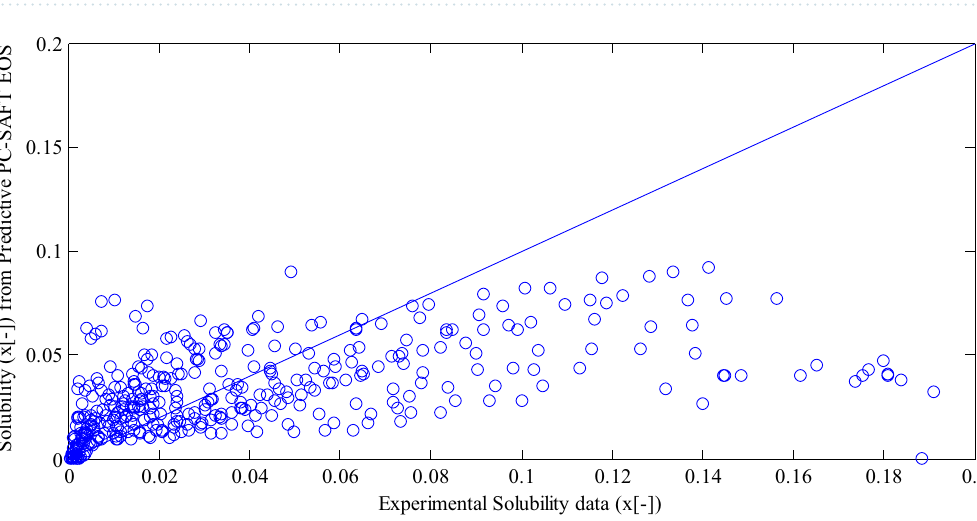
Figure 9. Parity plot of experimental solubility data (mole fraction) in binary solvents compared to calculated solubility data (mole fraction) from predictive PC-SAFT EOS